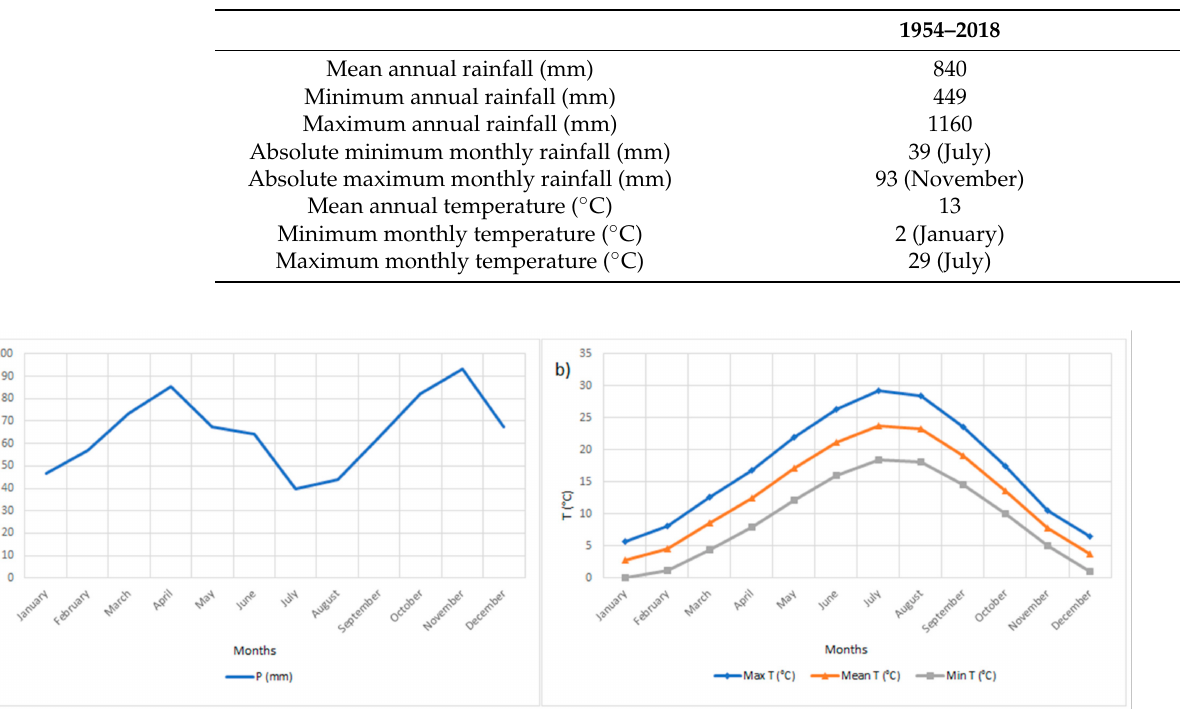
Table 1. Climate data of the study area.